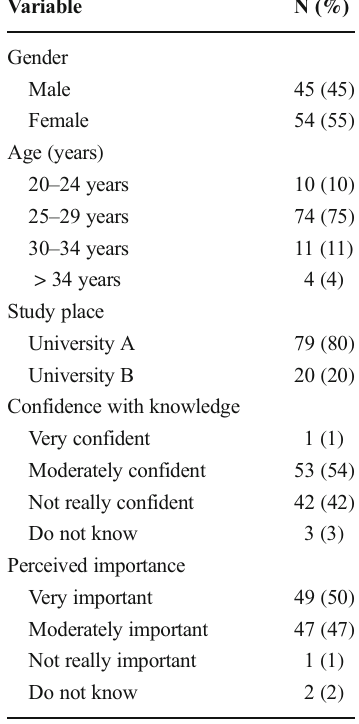
Table 1 Sociodemogra- phic characteristics